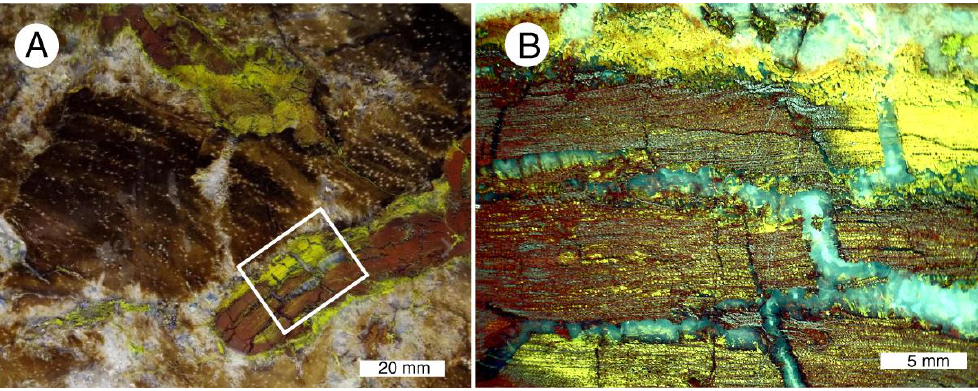
Figure 25. Volbrothite in “colla wood”. ( A ) This yellow mineral infiltrates marginal areas of brecciated silicified wood fragments, and fills the lumina of many cells. ( B ) Light-colored areas are chalcedony- filled fractures.